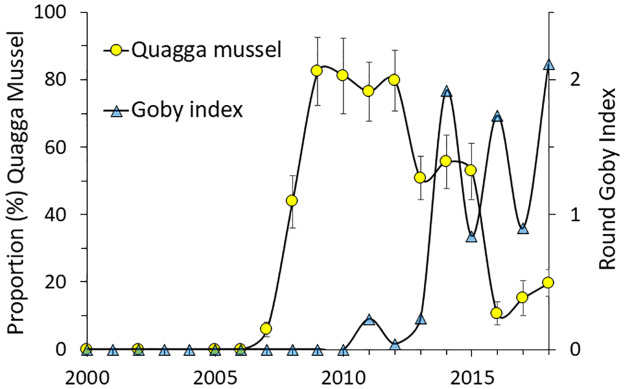
Proportion of the mussel biomass consisting of quagga mussels on bottom depths 0–4.5 m and an index of round goby abundance 2000–2018.The yellow circles are the proportion of quagga mussels (%), bars are ± 1 SE based on sites. Quagga mussel proportions for 2000 are from Spada et al. [46] and for 2002 are from a OCDWEP report [48]. Blue triangles represent the goby index calculated from beach seine and electrofishing surveys (see Methods).